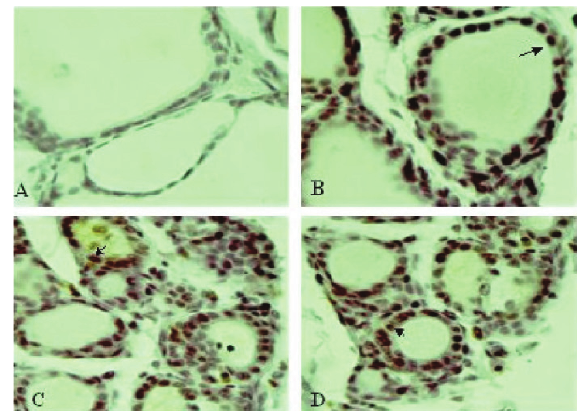
Figure 2- Photomicrograph of PCNA reaction in the central area of the right thyroid lobe of ovariectomized rats: A. ovariectomized animals treated with vehicle (GI); B. ovariectomized animals treated with conjugated equine estrogens (GII); C. ovariectomized animals treated with tamoxifen (GIII); D. animals in estrous phase treated with vehicle (GIV). The arrows show the positive reaction. (HE, x